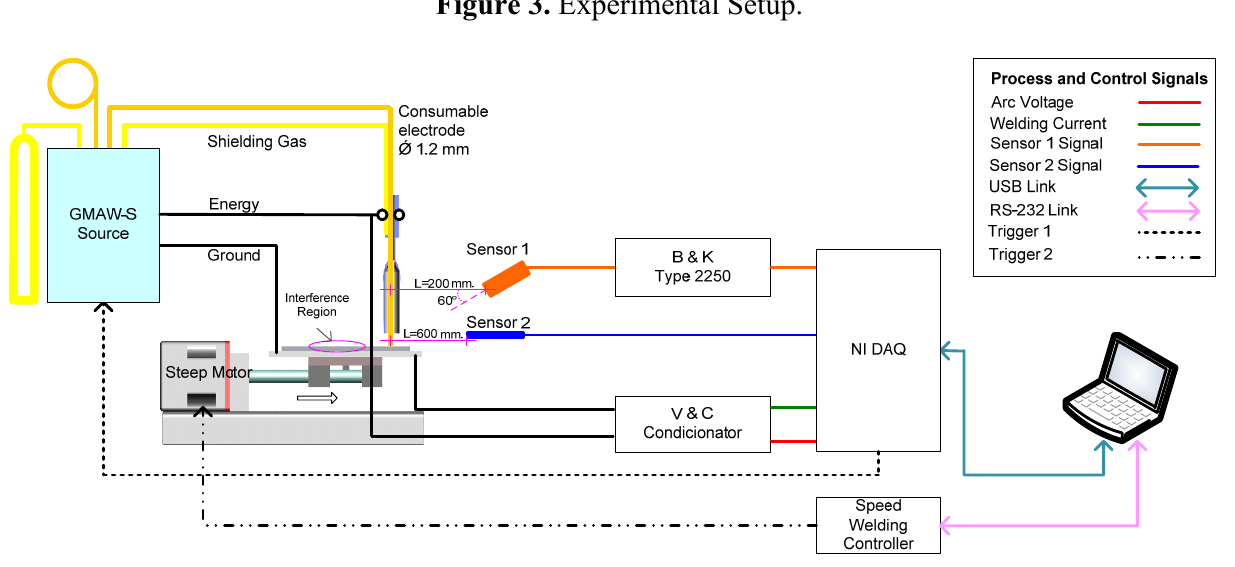
Figure 3. Experimental